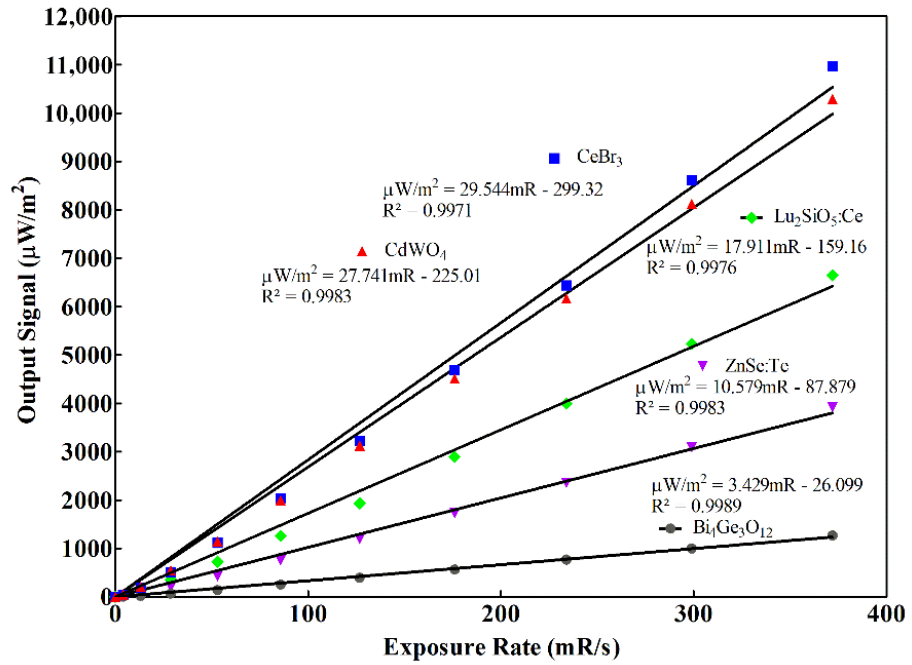
Figure 1. Output signal versus exposure rate. Absolute luminescence efficiency versus the X-ray tube’s high voltage is depicted in Figure 2 for each scintillator. Every material’s AE increases constantly with increasing high voltage. The relationship is linear for CeBr 3 within the intervals 50–80 kVp and 100–140 kVp, albeit at different slopes. CeBr 3 and CdWO 4 attain similarly high AE values, regardless of the former’s lower effective Z and density, thus demonstrating its excellent performance at light yield capacity. CeBr 3 reaches 29.5 EU at 140 kVp spectrum, the largest value of all examined materials. In the graph of the output signal versus exposure rate (Figure 1), the fitted lines’ slopes are in accordance with the relationship between the scintillators’ AE values (Figure 2). The decreased slope of the BGO line corresponds to inferior AE values. CeBr 3 and CdWO 4 output signal slopes stand higher and close to each other, similarly to the respective absolute efficiencies. Moreover, LSO:Ce and ZnSe:Te absolute efficiency curves, like the respective output signal slopes, stand halfway